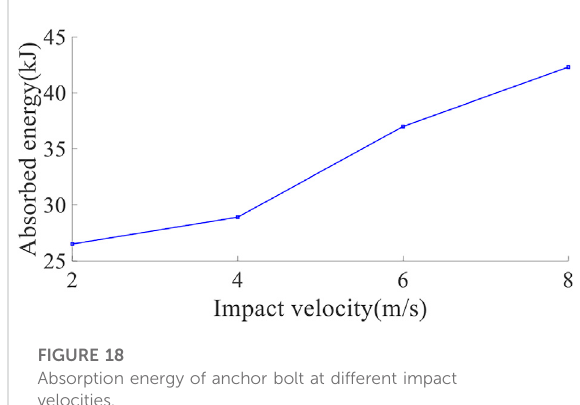
FIGURE 18 Absorption energy of anchor bolt at different impact